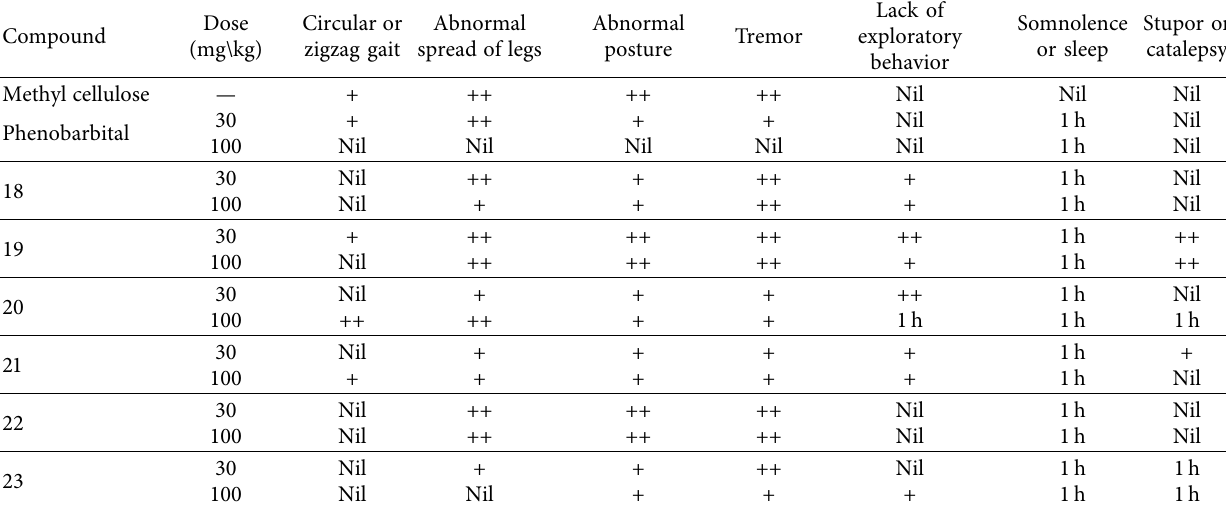
Table 4: Neurotoxicity ∗ of synthesized compounds during 1 hour of